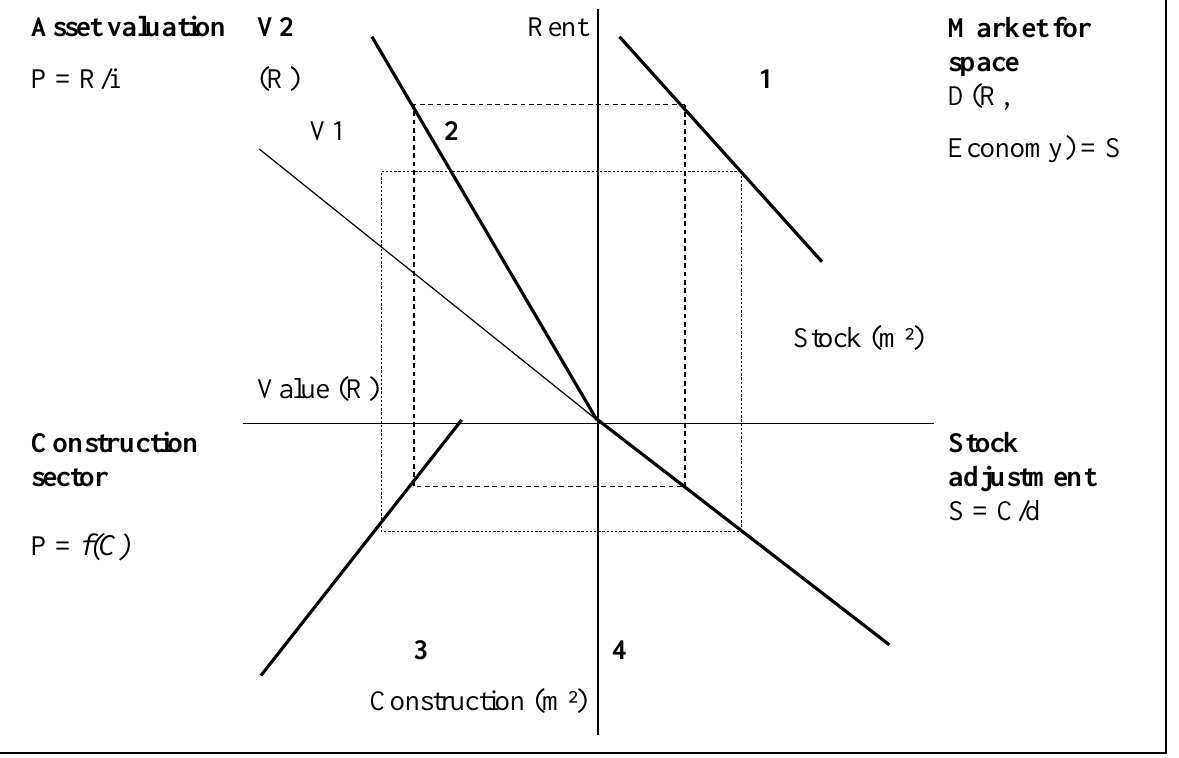
Figure 3 Shift in capitalisation rate in terms of the Pretoria IPAMM Asset valuation Market